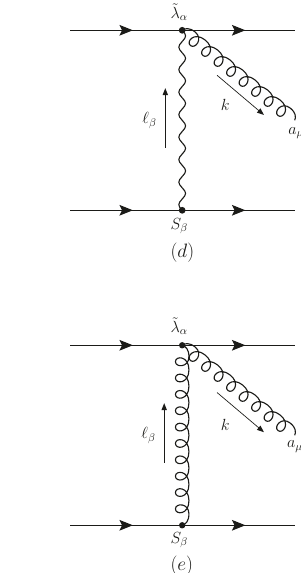
Figure 4 . Diagrammatics for leading order (cid:12)nite-size contributions from spinning sources at linear order in spin. The same symbols are used to represent the respective